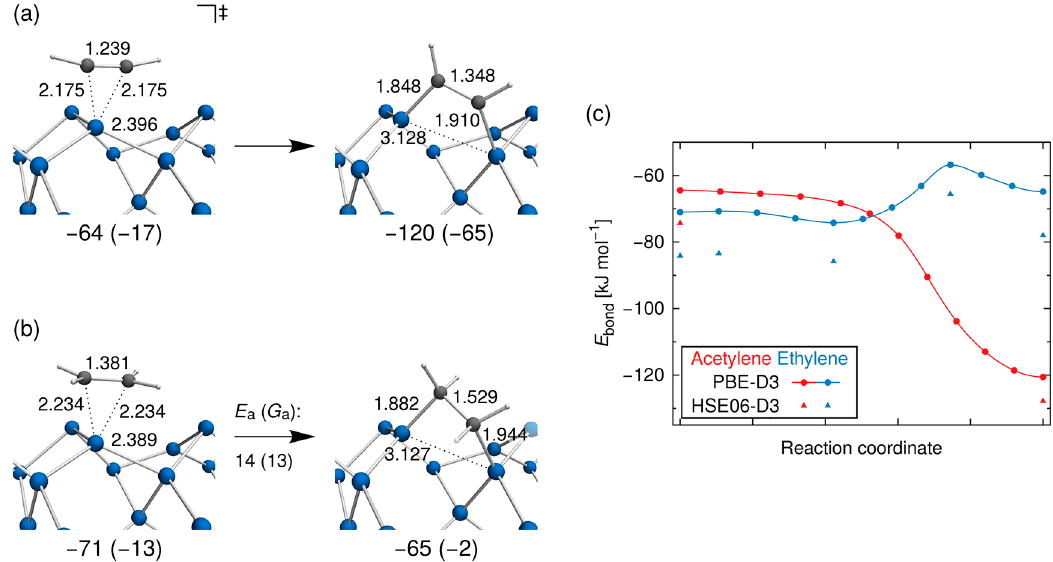
Figure 4. ( a , b ) Optimized structures and PBE-D3 E bond ( G bond ) values of the π complex (left) and sublayer (right) adsorption modes of acetylene ( a ) and ethylene ( b ) on Si(001). d (C–C ′ ), d (C/C ′ –Si down ), d (C ′ –Si sub ) and d (Si down –Si sub ) given in Å. ( c ) Corresponding reaction energy profiles (PBE-D3) and HSE06-D3 energies at the stationary points.